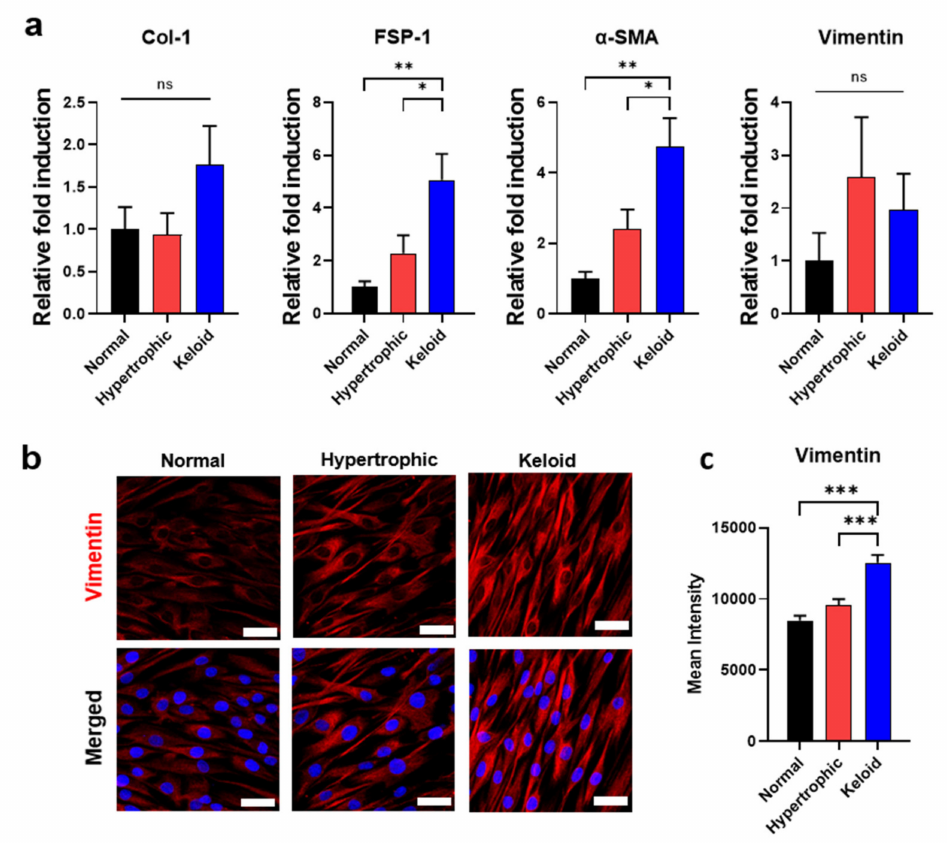
Figure 2. Isolation of dermal fibroblasts from NHK patient-derived skin tissues and their phenotypic characterization. ( a ) quantitative polymerase chain reaction (qPCR) of skin fibrosis and activation of myofibroblast-associated markers. ( b ) Immunofluorescence staining for vimentin (red) and nuclei (blue). Scale bar = 50 µ m. ( c ) Mean intensity values of vimentin protein expression quantified by MATLAB. Data represent the mean ± SEM. * p < 0.05, ** p < 0.01, *** p <